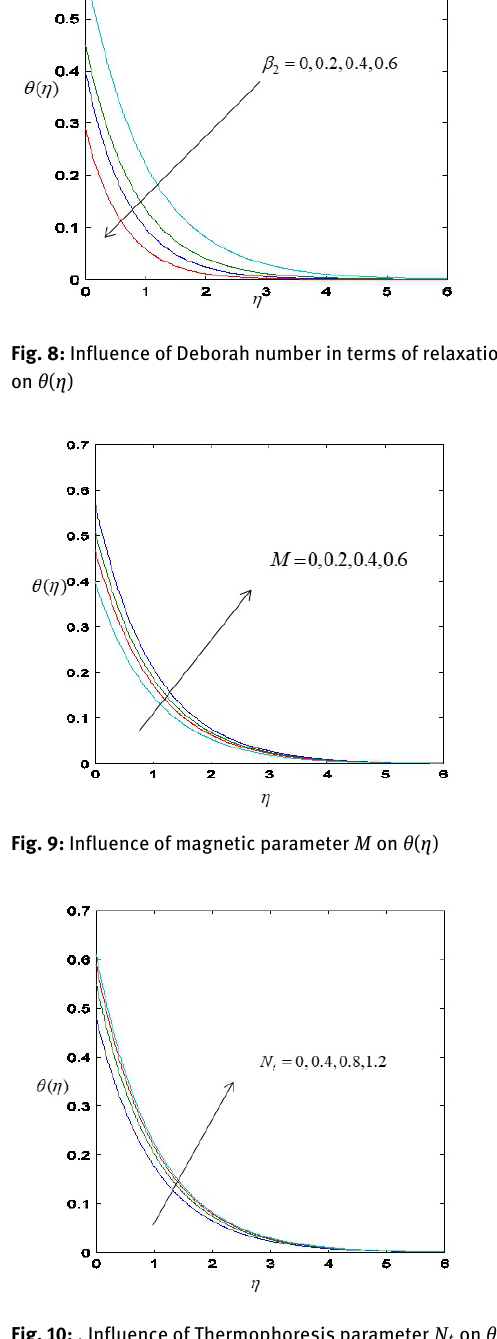
tration profile increases with increase of Nt . This is due